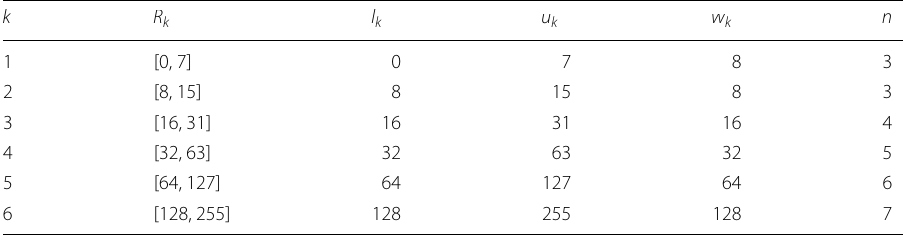
Table 1 Type 1 of the PVD interval classification